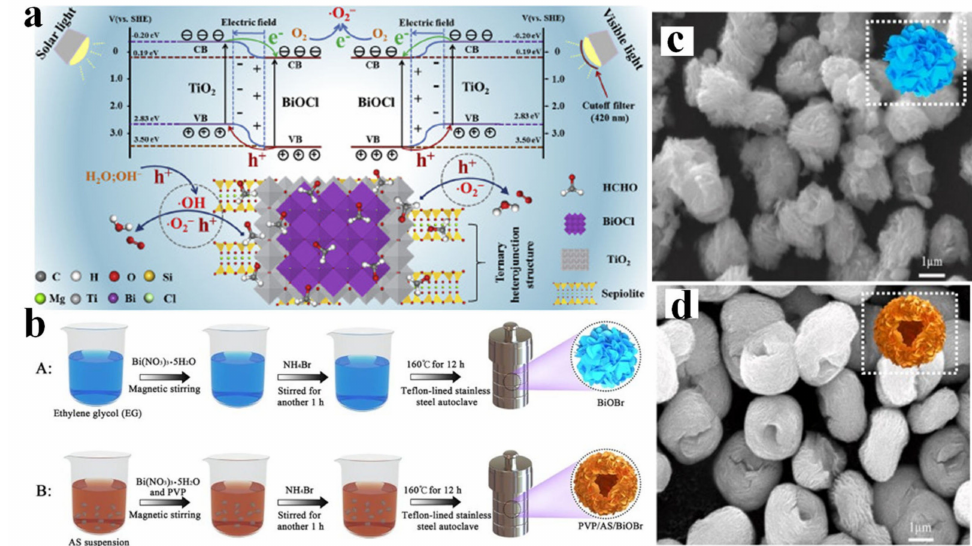
Figure 5. ( a ) Possible mechanisms for photocatalytic removal process of formaldehyde (HCHO) under solar and visible light irradiation on the BiOCl/TiO 2 /sepiolite (T − B − S − 500D) composite; ( b ) schematic illustration of the synthesis pathway and the structure schematic model of the compos- ites; SEM images of ( c ) pure BiOBr and ( d ) PVP/AS/BiOBr (6%). Adapted with permission